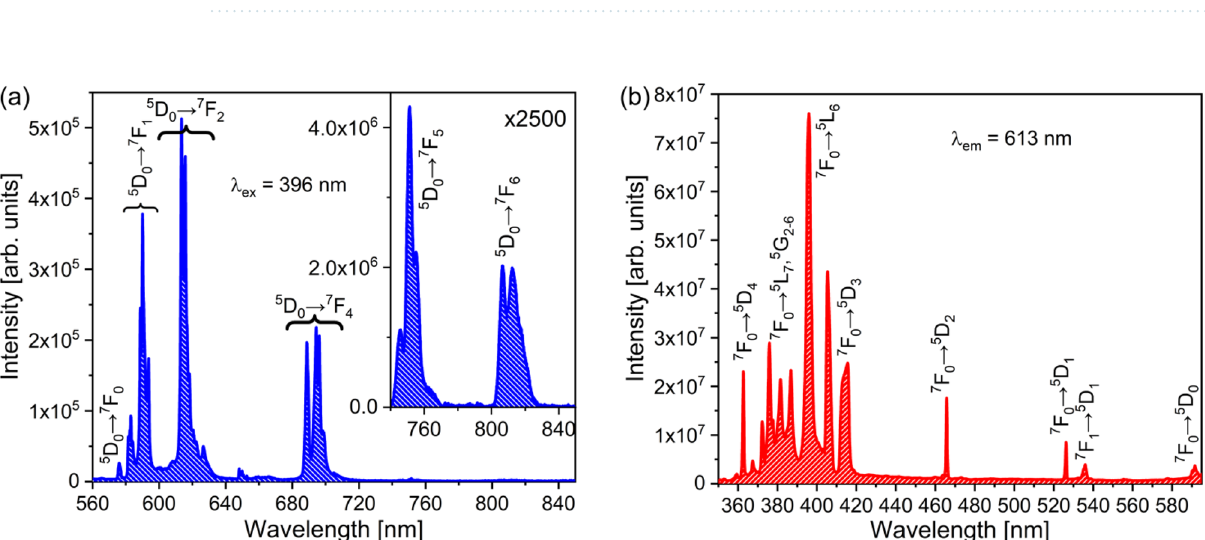
Table 2. JO parameters determined from the excitation spectrum of Y 2 SiO 5 :Eu 3+ and their comparison with the values obtained from its emission spectrum.